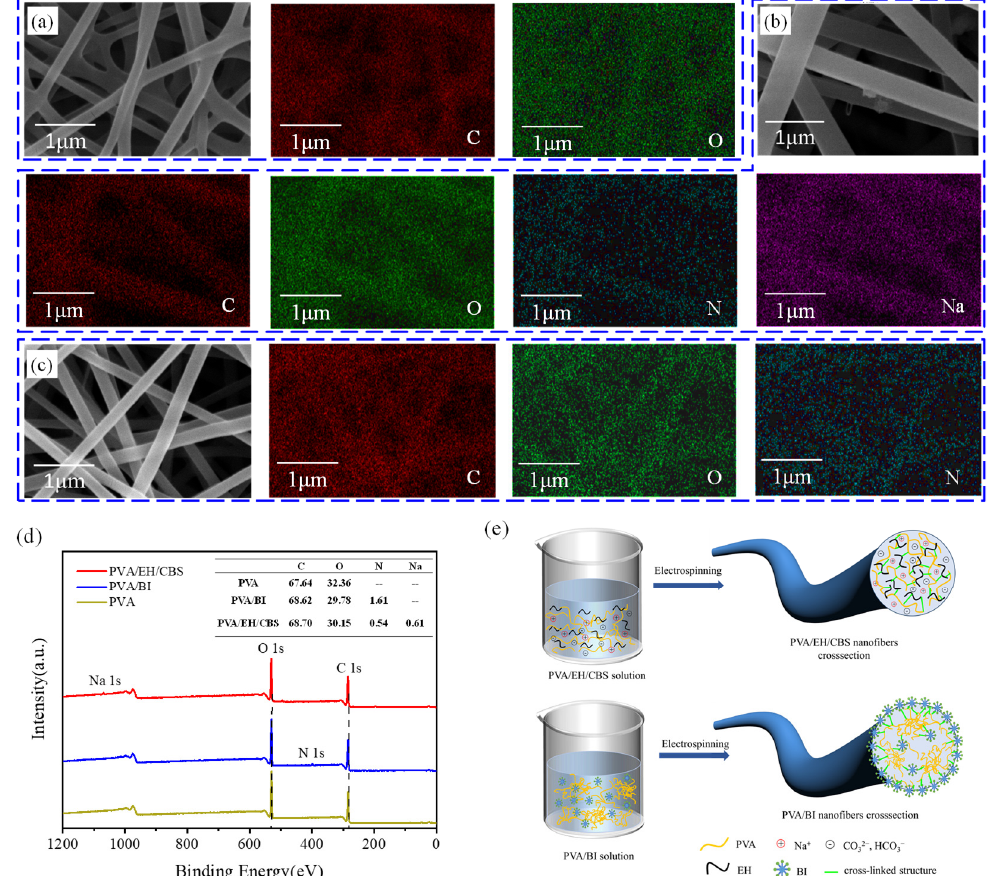
Figure 6. EDS mapping spectra of elements C, O, N and Na on ( a ) PVA, ( b ) PVA/EH/CBS and ( c ) PVA/BI nanofibers, ( d ) XPS spectra of PVA, PVA/EH/CBS and PVA/BI nanofibers, ( e ) Schematic illustration of distribution of PVA/EH/CBS and PVA/BI in the dispersions.